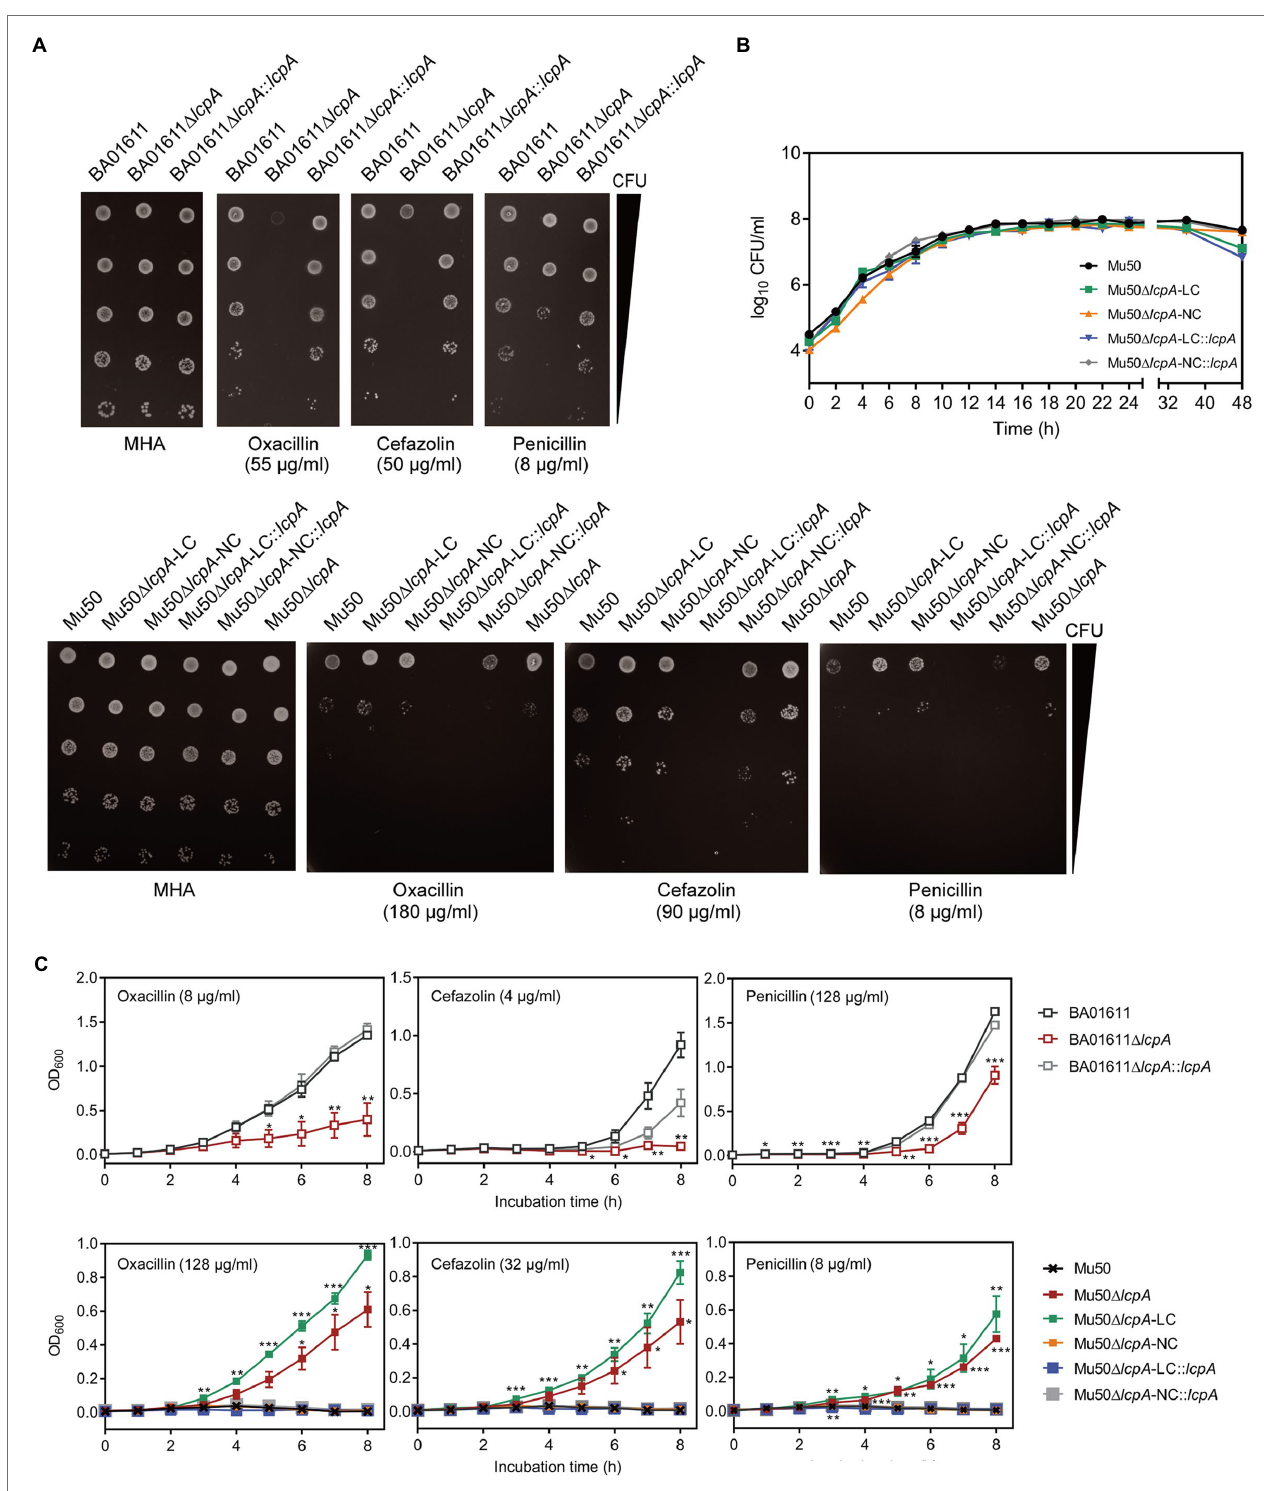
FIGURE 2 | β -Lactam susceptibility assay for BA01611 and Mu50 isogenic strains. (A) β -Lactam resistance was measured by agar dilution for BA01611 and Mu50 isogenic strains. Bacteria cultures were diluted from 10 8 to 10 4 CFU/ml, then 1 μ l of bacterial suspensions was spotted on the MHA + 2% NaCl medium with different antibiotics. Images of MHA plates represent one out of three experiments showing similar results. (B) Growth curves of Mu50 isogenic strains in TSB without antibiotics showing by CFU/ml. (C) Growth curves of BA01611 and Mu50 isogenic strains in TSB with β -lactams showing by OD 600 . Error bars correspond to SEM from three independent experiments. One-way ANOVA with LSD or Dunnett’s T3 test for multiple comparisons, * p < 0.05, ** p < 0.01, *** p <